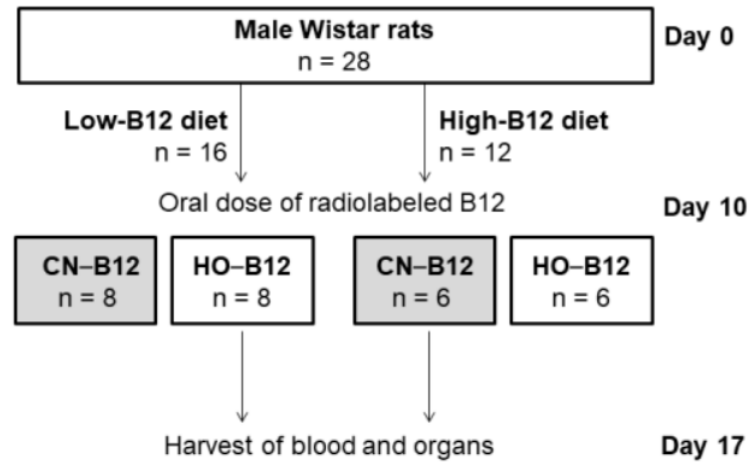
Figure 1. Study design. Abbreviations: CN–B12: [ 57 Co] cyano–B12 (CN–B12); HO–B12: [ 57 Co] hydroxo–B12 (HO–B12).